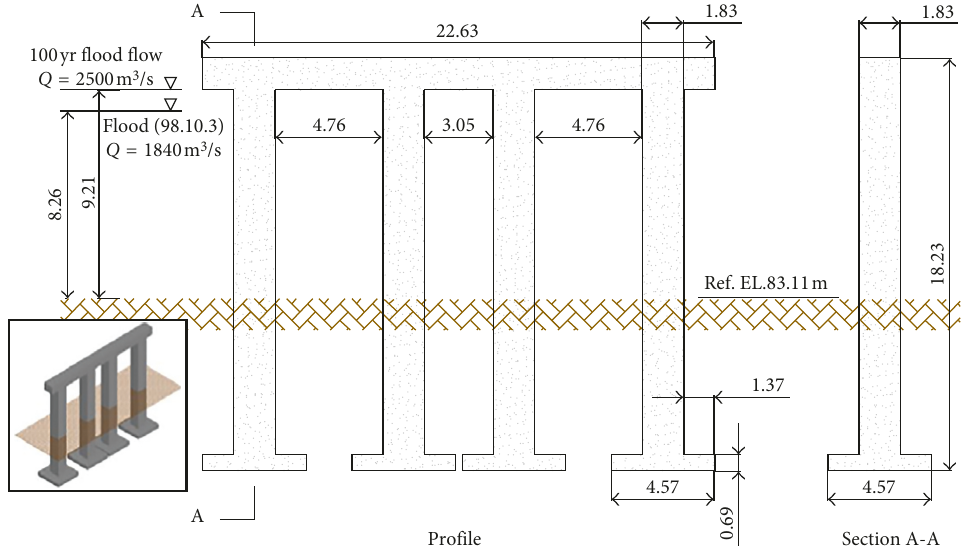
Figure 3: Dimensions of the central bridge pier bent in Ocmulgee River at Macon, Georgia (prototype dimensions in